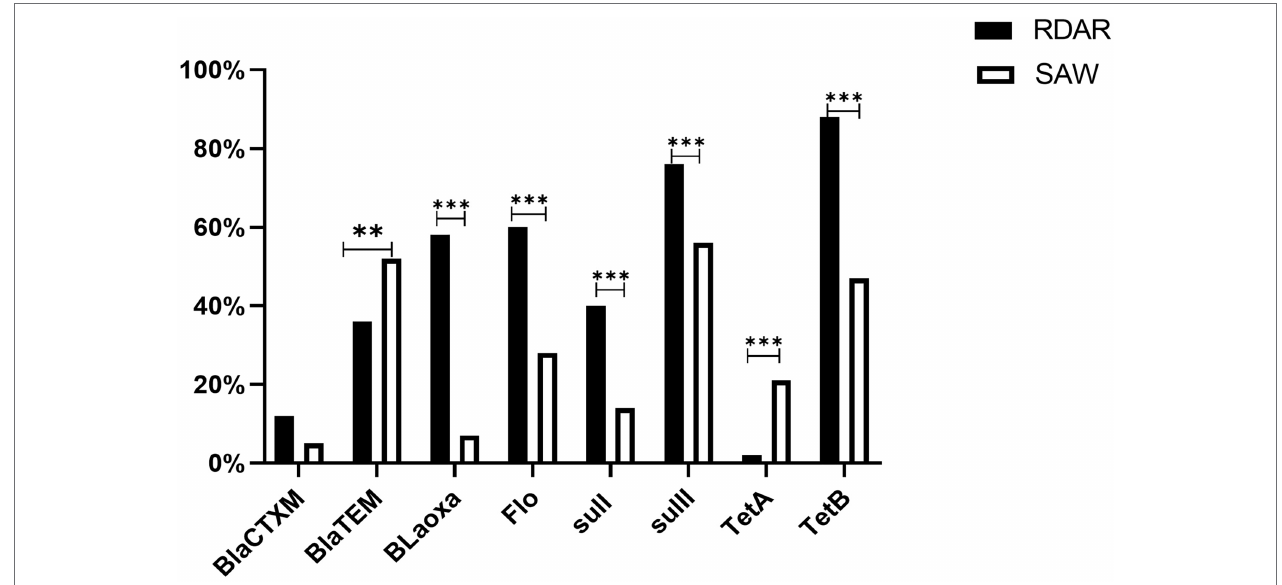
FIGURE 6 | Antimicrobial resistance genes of ACSuT, Ampicillin, Chloramphenicol, Sulfamethoxazole, and Tetracycline. Among them, BlaCTXM, BlaTEM, and Bloxa are β -lactam resistance genes, Flo is Phenicols resistance genes, sulI and sulII are Sulphonamide resistance genes, TetA and TetB are Tetracycline resistance genes, mcr-1 is the Polymyxin B resistance gene, and BlaNDM-5 is the Imipenem resistance gene (** p < 0.01 and *** p <